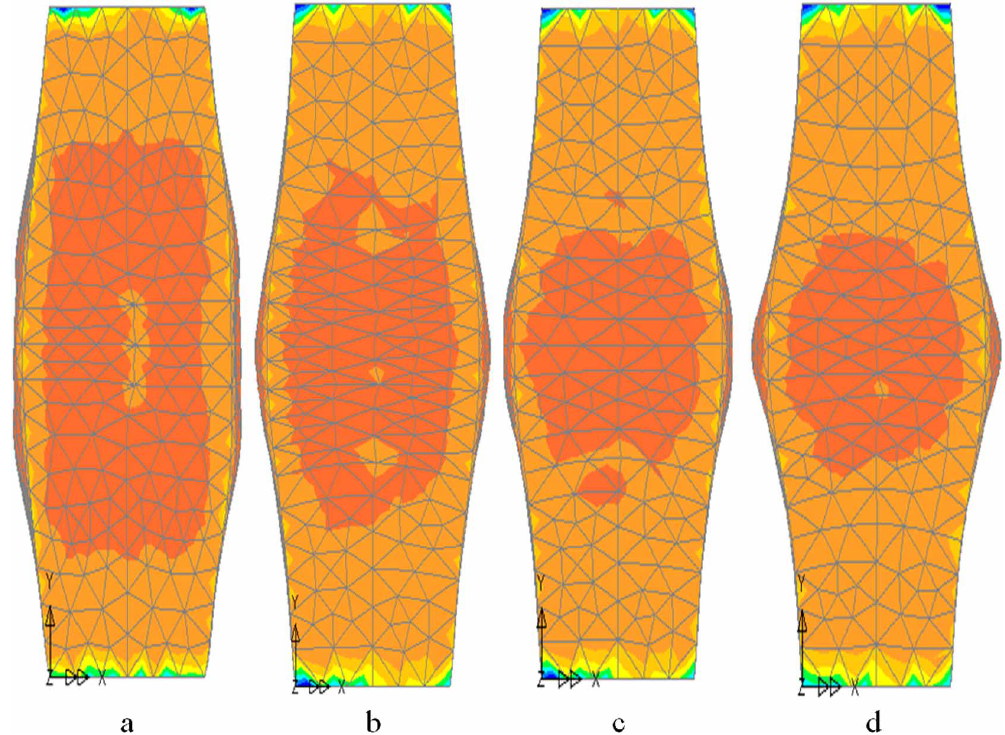
Fig. 18. Typical failure modes of the CFSC stub columns in the elevation: (a) column with 3 bar stiffeners and spacing of 50 mm; (b) column with 4 bar stiffeners and spacing of 100 mm; (c) column with 3 bar stiffeners and spacing of 150 mm; (d) column with 4 bar stiffeners and spacing of 150